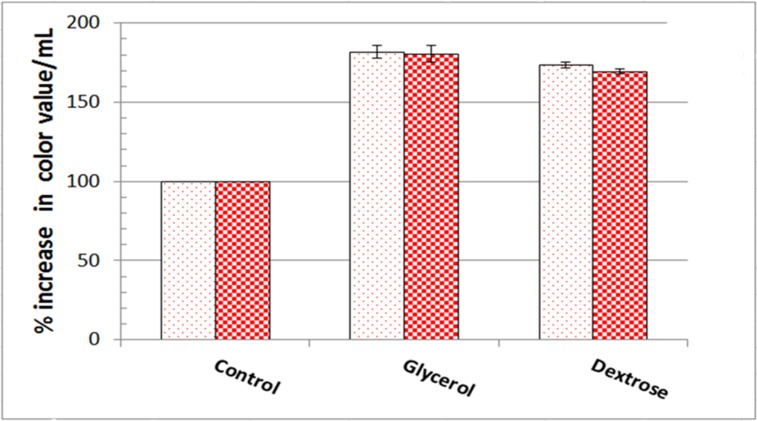
Effect of glucose and glycerol on orange and red monascus pigments production.Dotted bars: orange moanscus pigments. Checkboard bars: red monascus pigments.